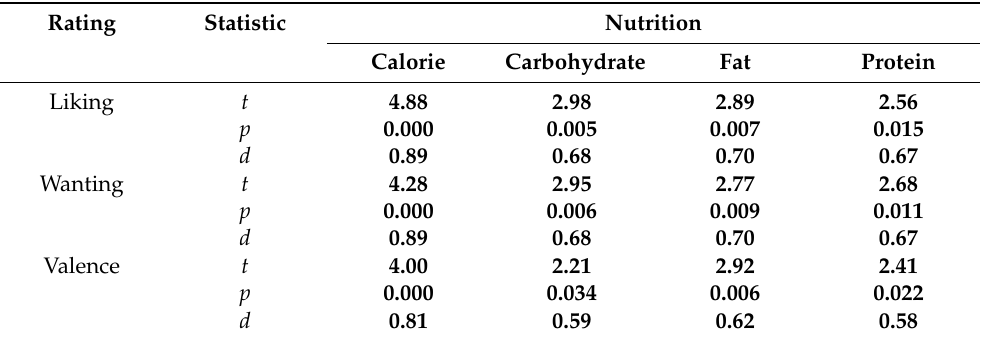
Table 4. Results of dependent t -tests (two-tailed; t -, p -, and Cohen’s d -values) contrasting correlation coefficients between zygomatic major muscle activity and hedonic ratings with those between muscle activity and nutritional